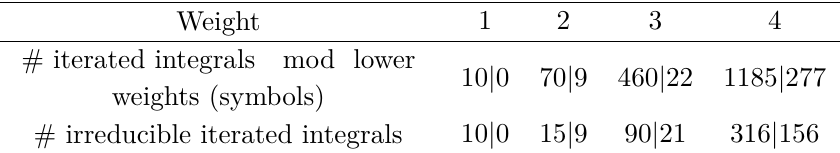
Table 3. Number of the parity even | odd independent iterated-integral solutions of DEs (4.1) for all four topologies and all 5! orientations